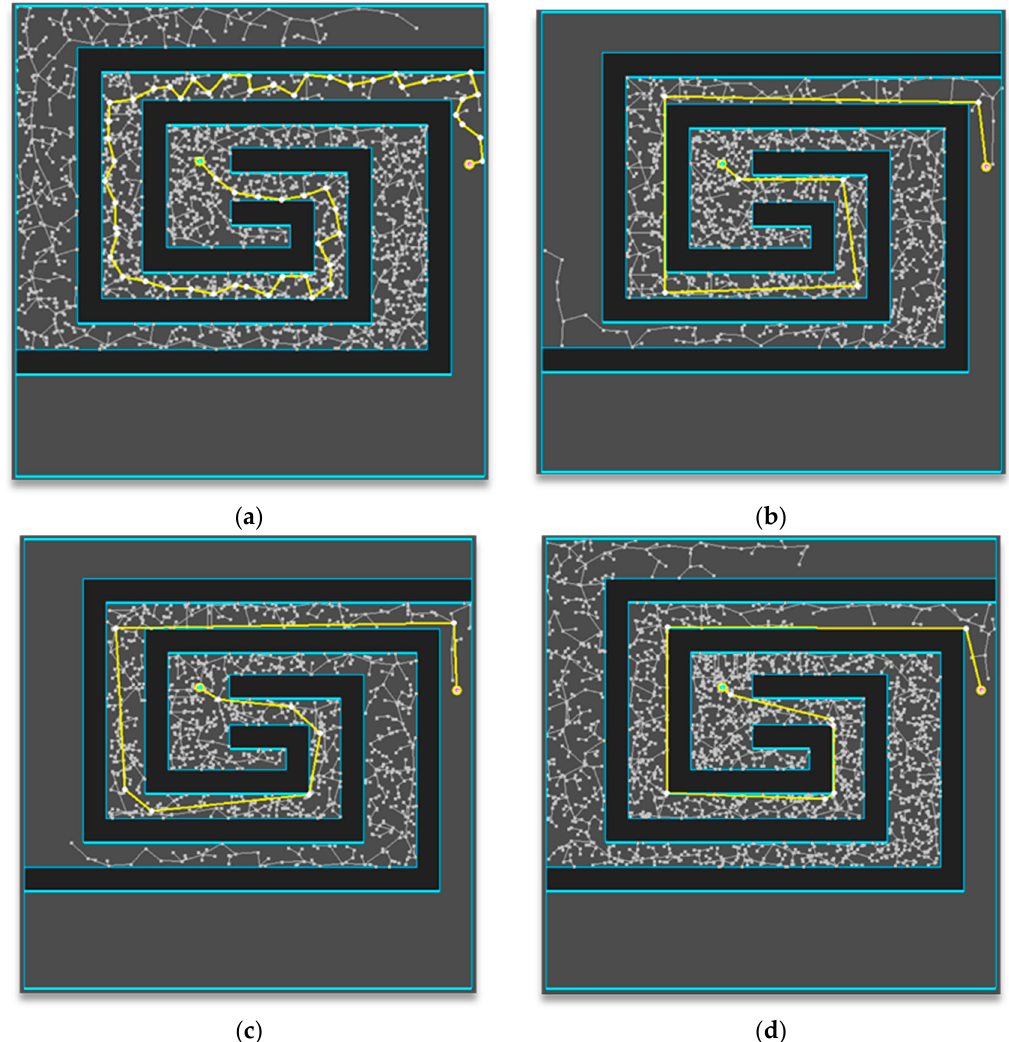
Figure 12. Experimental results of Map 4: ( a ) RRT; ( b ) Proposed method ( ε : 50 px) applied; ( c ) Proposed method ( ε : 30 px) applied; ( d ) Proposed method ( ε : 10 px)